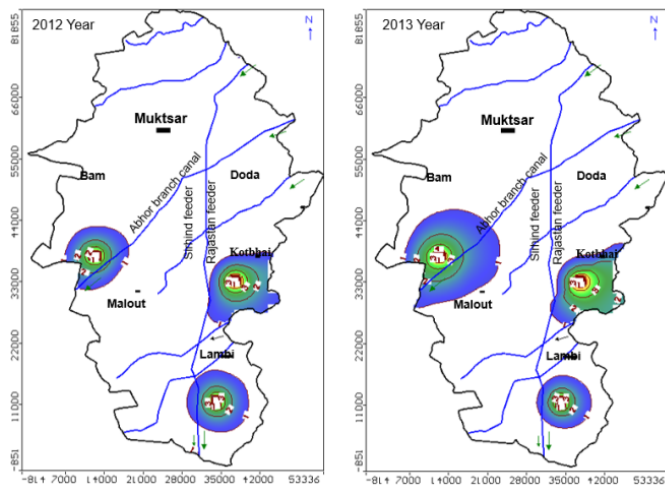
Figure 8. Groundwater level depletion at the end of 2011 and 2013 due to GEP with reference to 2011 water levels ( x ‐ and y ‐ axes are in m).